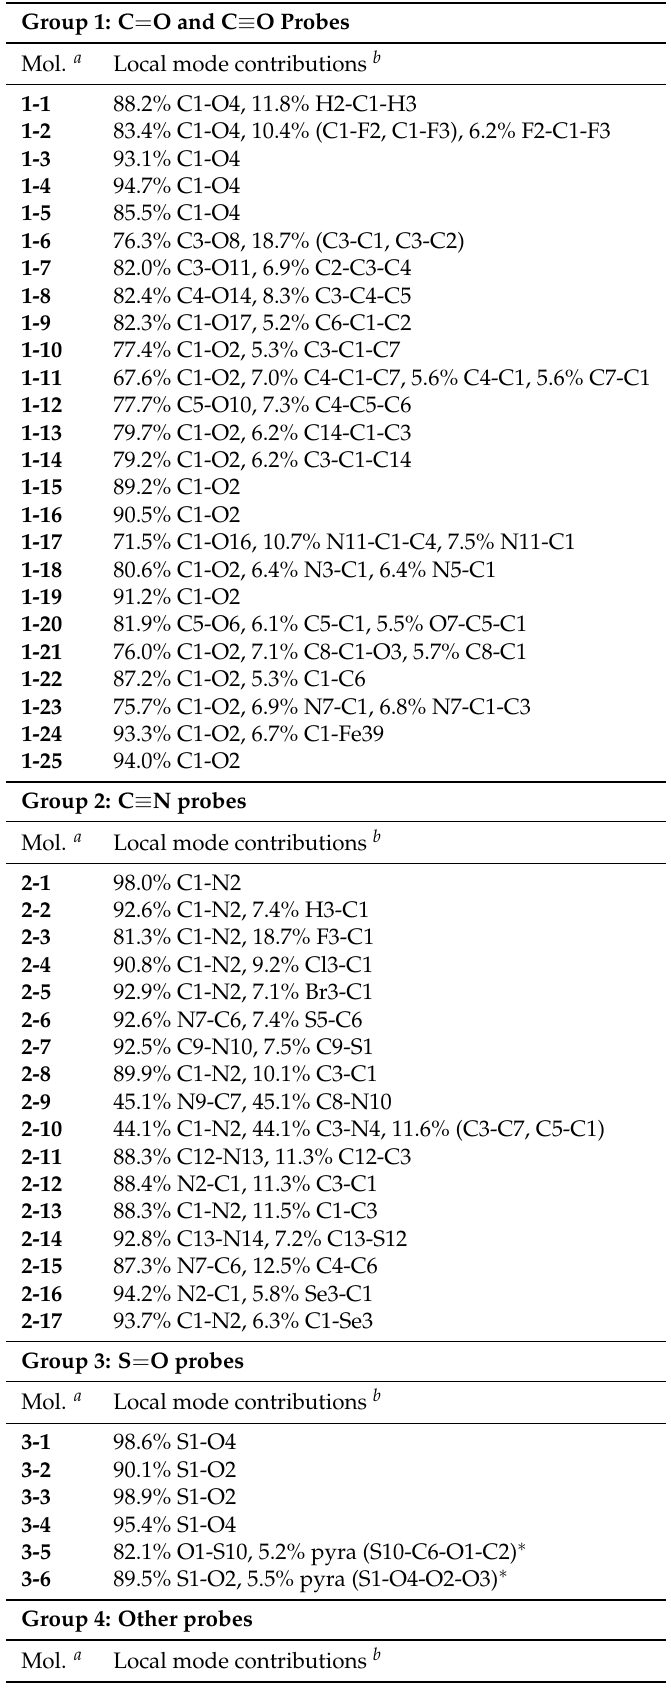
Table 1. Decomposition of target normal mode of probe bond stretching into local